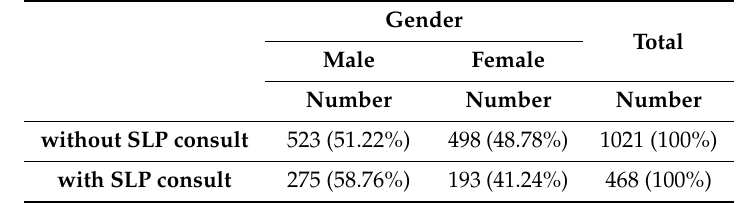
Table 3. SLP consults from each gender category.